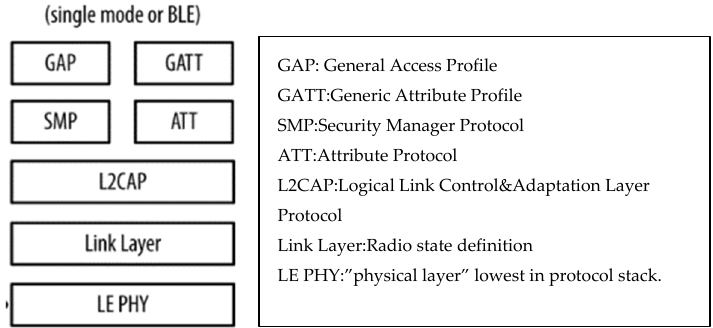
Figure 23. BLE protocol stack that allows meshed and long-range links.